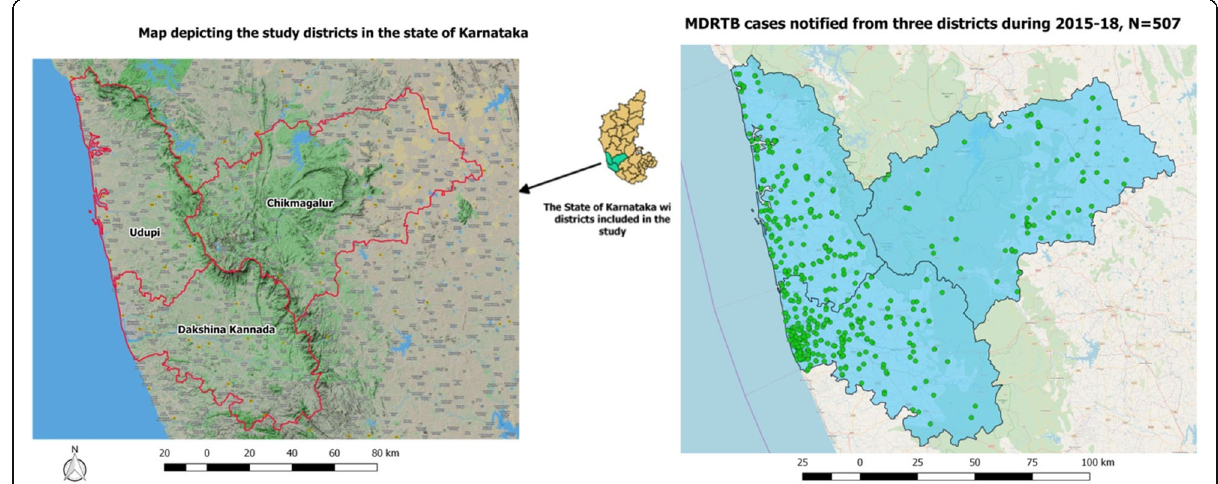
Fig. 1 The map depicting the study districts and spot map of drug-resistant TB patients in the state of Karnataka,